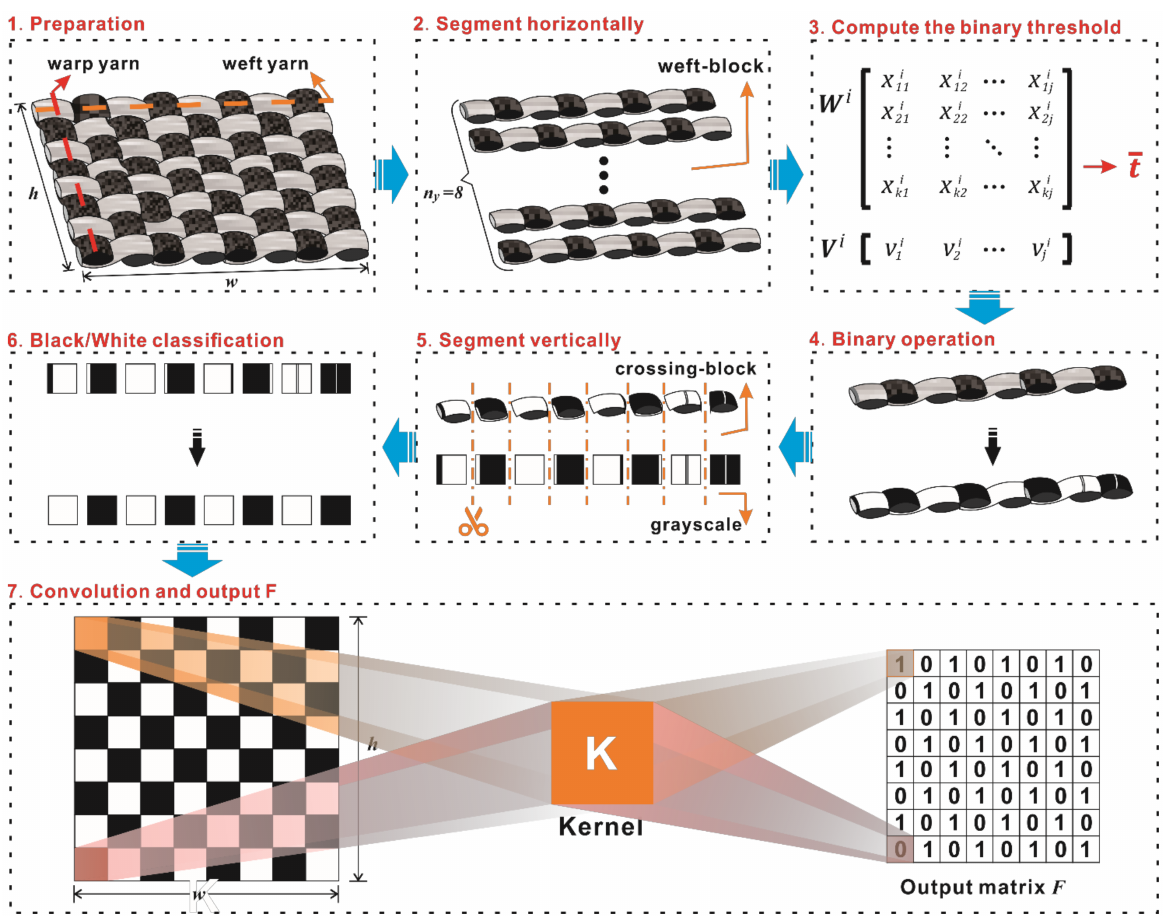
Figure 1. The schematic of texture features in the compression